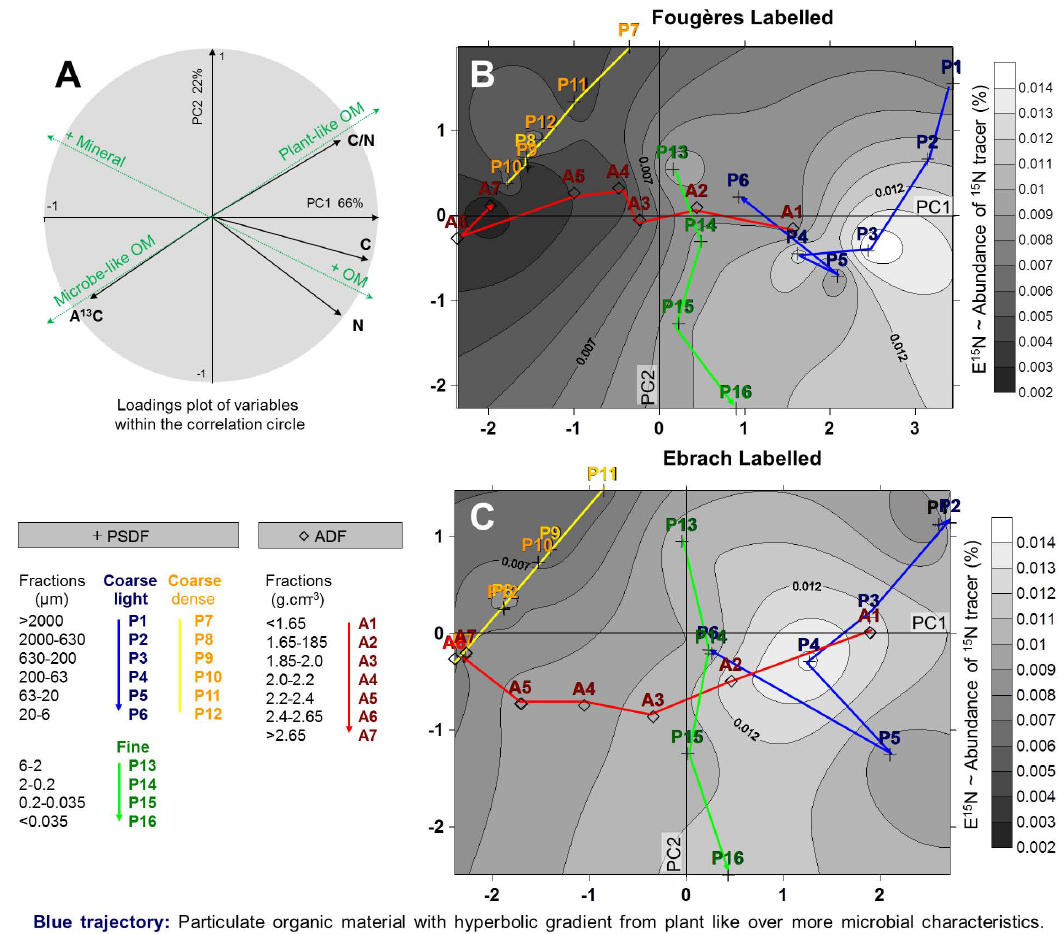
Fig. 4. Principal component analysis (PCA). PCA was performed for both sites independently on fractions isolated from labelled and unla- belled soil samples. Fractions were discriminated as a function of their C and N content, C/N ratio and the abundance of 13 C, A 13 C. (A) Correlation circle between the new components and the original variables. (B) and (C) Score plots for labelled soil fractions only. Visual- isation of 15 N tracer abundance (see Equation A) within fractions was performed by applying the relevant contour map as a background image. Interpolated contour maps were obtained by kriging using a default linear variogram (slope = 1, nuggets effects = 0) using the soft- ware “Surfer” v. 7.02). Fractions are grouped for similarity based on their level of affiliation with one of four clearly discernible trajectories (indicated by line style) within the PCA plane. A synthetized representation of the PCA results as well as its visual interpretation is given in Figs. 5 and